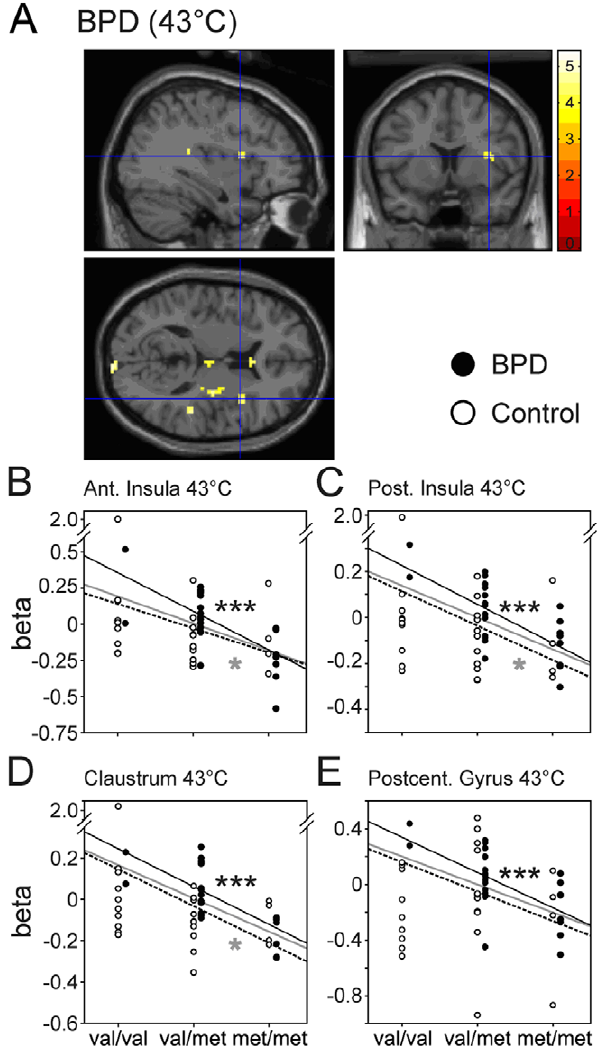
Figure 4. Association between COMT genotype and fMRI activation during painful stimulation in the anterior and posterior insula. Significant correlations were observed during condition 1 within the anterior (A,B) and posterior insula (C), claustrum (D) and postcentral gyrus (D). Labeling as in Fig. 2, * p , 0.05, ** p , 0.01.